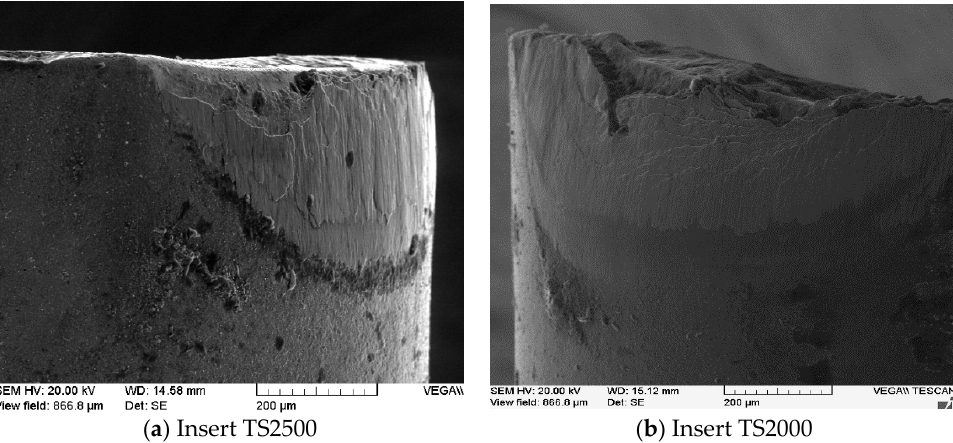
Figure 11. The SEM images of flank wear on both inserts after 120 s cutting. ( a ) Insert TS2500. ( b ) Insert TS2000.